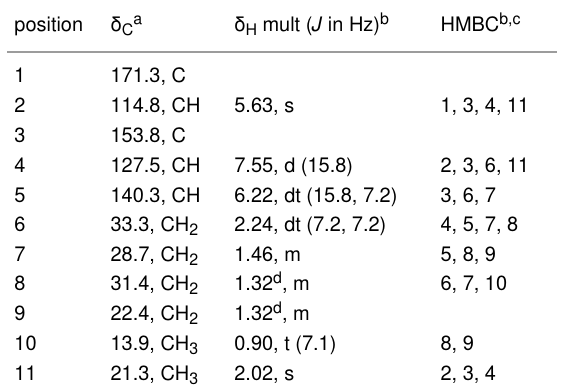
Table 1: 1 H and 13 C NMR data for compound 1 in CDCl 3 .